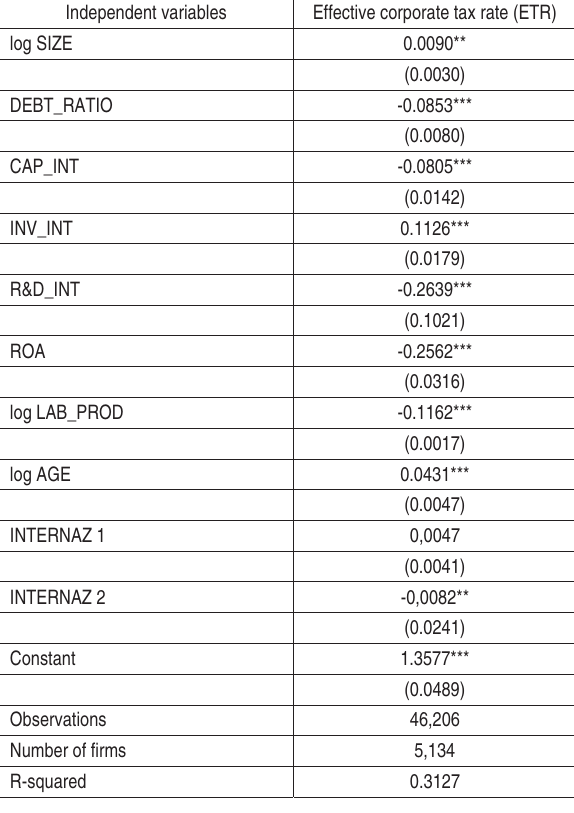
Table 4. Fixed effects panel regression